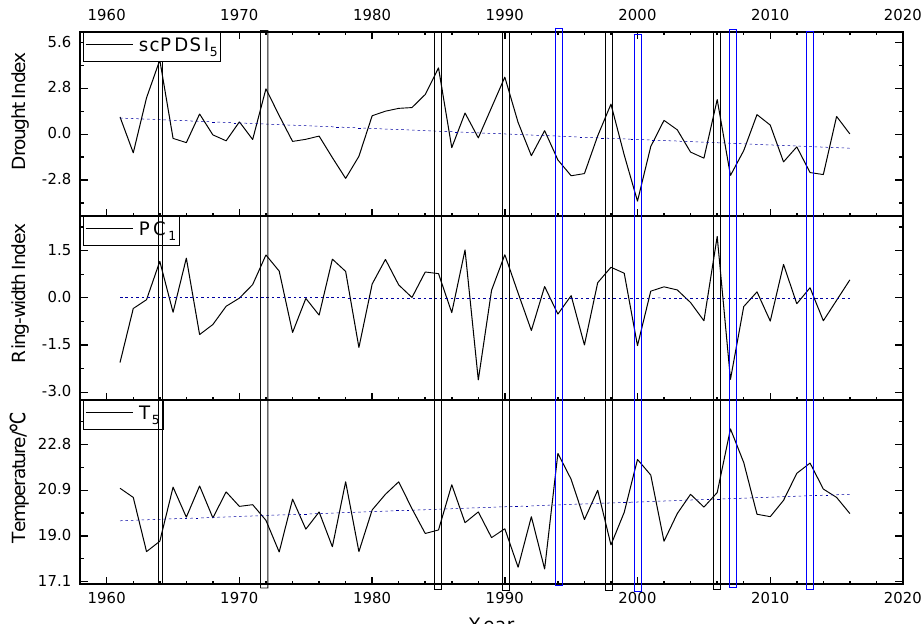
Figure 7. Comparison of PC 1 with T and scPDSI in May from 1961–2016. The black rectangles represent higher scPDSI, while the grey rectangles represent higher T in May.